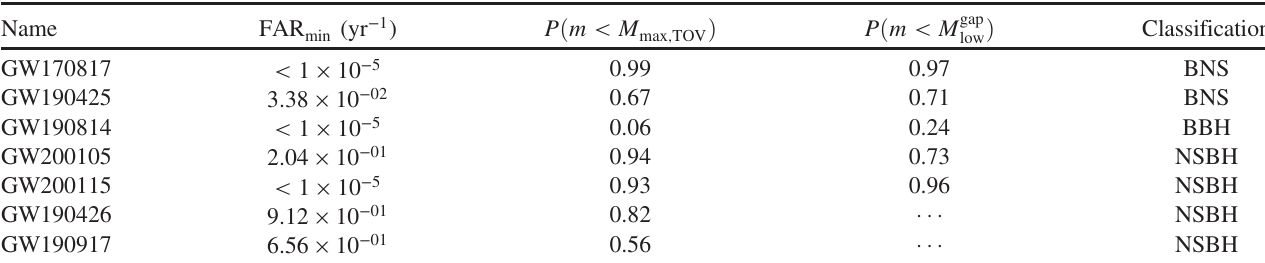
TABLE III. Classifications for low-mass events from Table I. The probability that a component is compatible with a NS is measured by the fraction of its mass posterior lying below an estimate [25] of the maximum nonrotating NS mass, M marginalized over statistical uncertainties. We adopt a 50% threshold for classification as a NS, assuming a clean separation between NS and BH mass spectra. Probabilities are reported relative to a uniform prior on the component mass. They refer to the secondary component of all events except GW170817 and GW190425, in which case the secondary is securely below the maximum NS mass and the probability for the primary is given. The probabilities are similar and the classifications are unchanged when the component masses M ⊙ , the location of the lower mass gap between NSs and BHs inferred from Sec. IV ’ s PDB analysis of are compared to M gap ¼ 2 . 1 þ 0 . 8 − 0 . 6 low the FAR < 0 . 25 yr − 1 events.